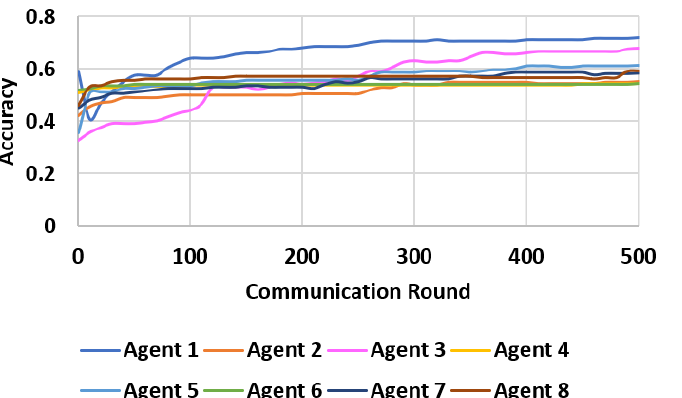
Figure 24. FedResilience’s impact on participating FL agents’ (eight agents and six stragglers) model accuracy for the prediction of CIA